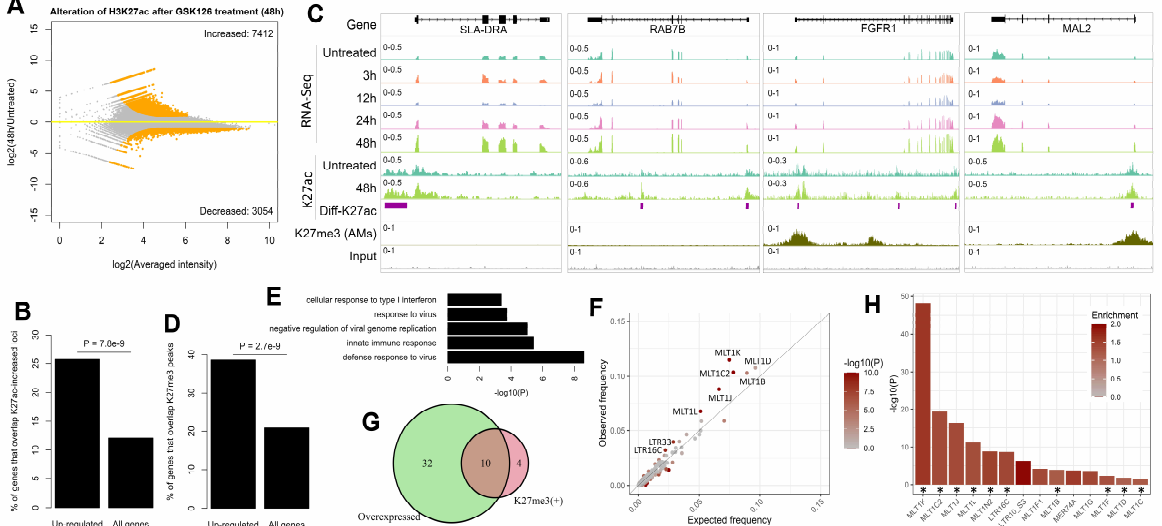
Figure 5. Epigenetic patterns for the activated genes and derepressed retrotransposons after the in- hibition of EZH2. ( A ) MA plot shows the altered occupancy of H3K27ac after inhibition of EZH2 in porcine 3D4/21 AMs. The significant differential loci are indicated by orange color. ( B ) Barplot shows that H3K27ac-increased loci are overrepresented near upregulated genes. The two bars rep- resent the percentages of genes (significantly upregulated genes vs. all genes) that overlap the loci with significantly increased H3K27ac intensity. An H3K27ac-increased peak was considered to overlap a gene if it fell within +/- 1 kb of the corresponding transcription start site (TSS). p-value calculated by using binomial test is indicated. ( C ) Integrative Genomics Viewer (IGV) tracks show the differential expression and differential H3K27ac occupancy after inhibition of EZH2 on repre- sentative genes, including SLA-DRA, RAB7B, FGFR1, and MAL2. H3K27me3 mark for porcine AMs is also indicated. Loci with significantly altered intensity of H3K27ac (abbreviated as Diff-K27ac) between GSK126-treated (48h) and untreated 3D4/21 AMs are indicated as purple bars in the IGV tracks. ( D ) Barplot shows that the upregulated genes after inhibition of EZH2 are more likely to overlap H3K27me3 peaks. The two bars represent the percentages of genes (significantly upregu- lated genes vs. all genes) that locate within H3K27me3 domains. A gene was considered to be within an H3K27me3 domain if its TSS overlaps any H3K27me3 peaks. p-value calculated by using bino- mial test is indicated. ( E ) Top five GO terms enriched within upregulated genes that are out of H3K27me3 domains. ( F ) Scatter plot shows the enrichment of specific ERV families within H3K27me3 domains. ( G ) Venn diagram shows the overlap of the ERV families upregulated after inhibition of EZH2 and overrepresented within H3K27me3 domains. ( H ) ERV families that are sig- nificantly enriched within H3K27me3 domains. Those also upregulated after inhibition of EZH2 are indicated by stars at the bottom.